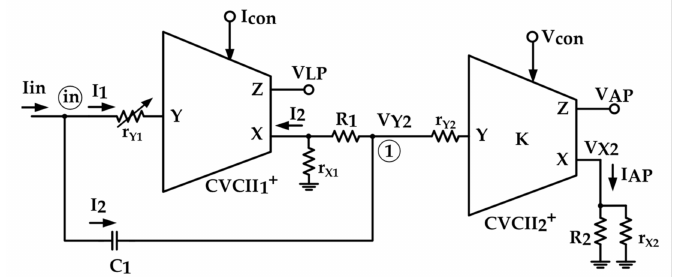
Figure 4. The proposed LP/AP filter topology (shown in Figure 2) in nonideal